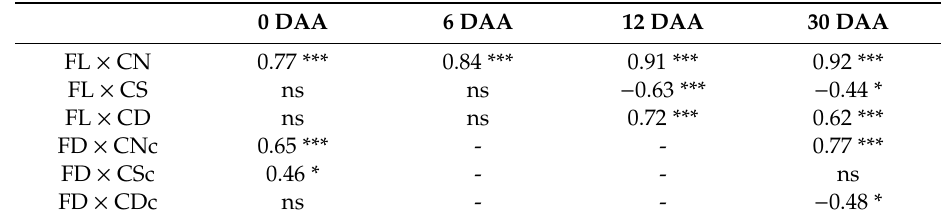
Table 3. Pearson correlation coe ffi cients among fruit length and diameter and the cell number, size, and density at di ff erent development stages. 0 DAA 6 DAA 12 DAA 30 DAA FL × CN 0.77 *** 0.84 *** 0.91 *** 0.92 *** FL × CS ns ns − 0.63 *** − 0.44 * FL × CD ns ns 0.72 *** 0.62 *** FD × CNc 0.65